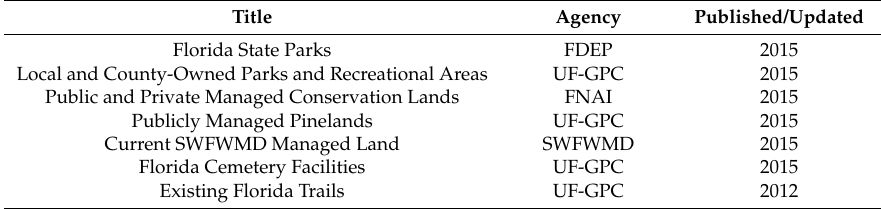
Table 1. Datasets used to create the Restricted Areas LULC map for model